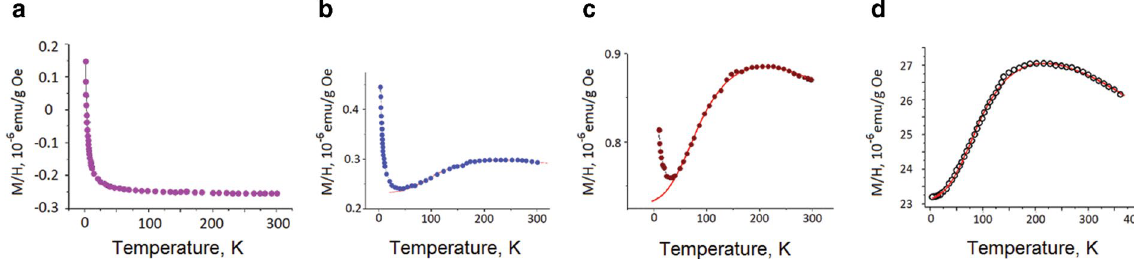
Figure 2. Evolution of magnetic susceptibility vs . temperature upon ageing of C 2 F x ( x < 1): ( a ) A Curie-like spin magnetism observed in as prepared samples; ( b ) and ( c ) progressive changes after few months of storage; ( d ) after 1